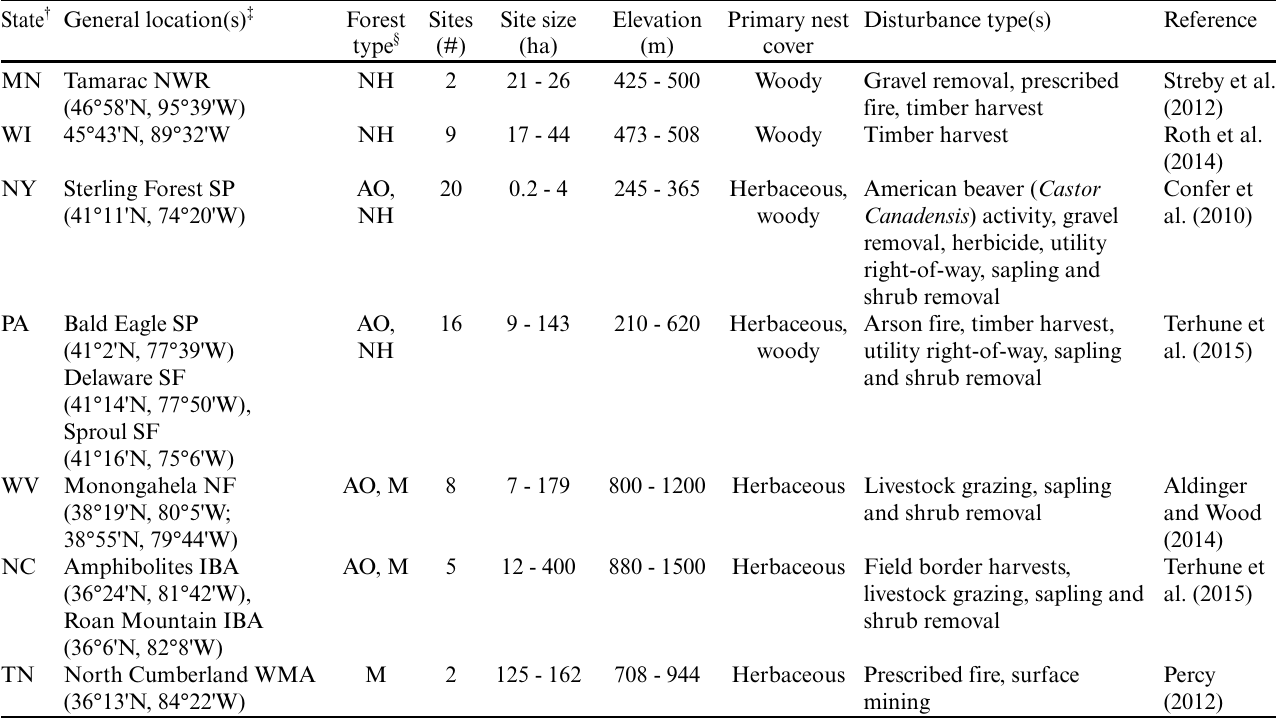
Table 1 . We monitored Golden-winged Warbler ( Vermivora chrysoptera ) nests (n = 388) at multiple sites (n = 62) across seven states, representing the vegetation communities commonly used for nesting (Confer et al. 2011).